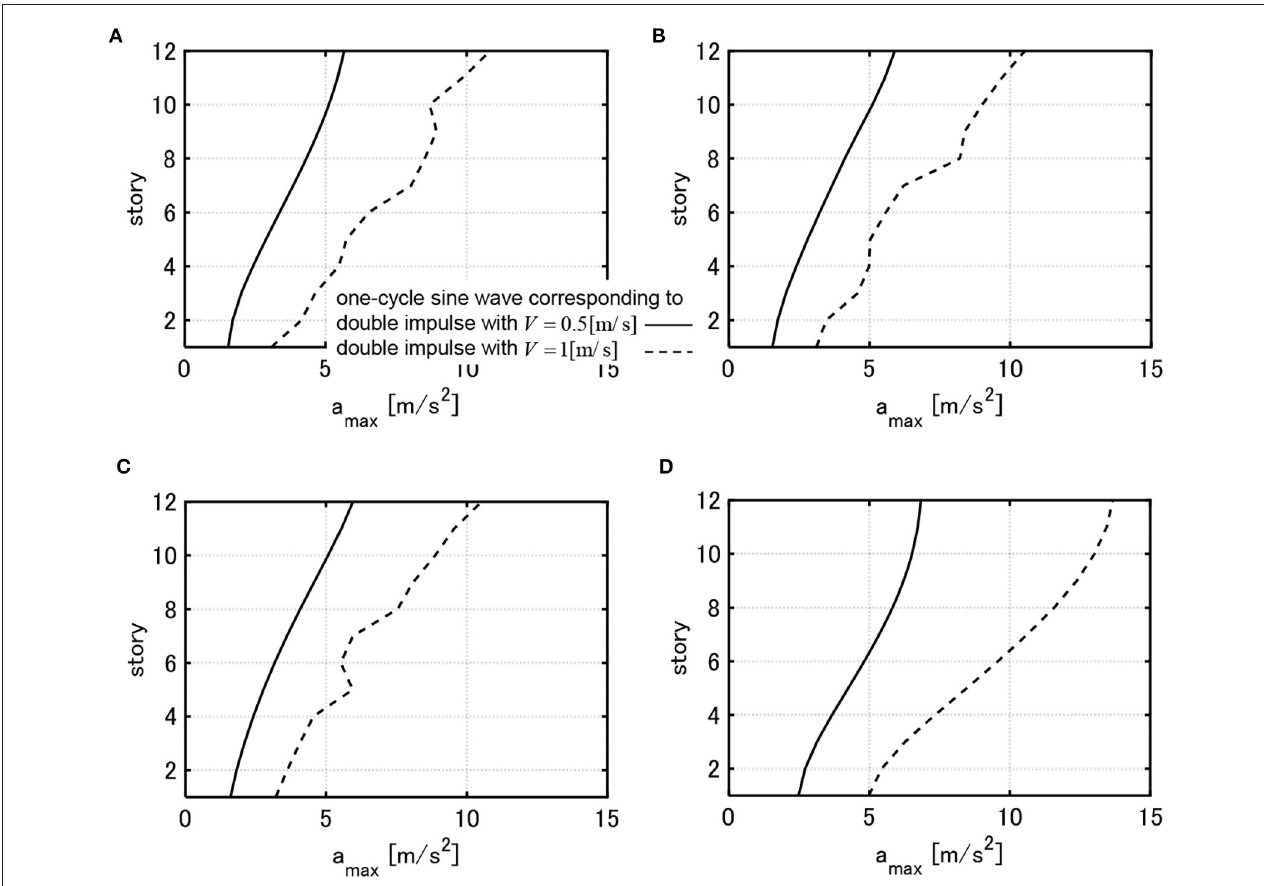
FIGURE 14 | Maximum floor acceleration of 3 models with W cF = 5 × 10 7 [ Ns / m ] and these initial design model under one-cycle sine wave corresponding to critical double impulse with V = 0.5, 1.0[ m / s ]. (A) Model designed under critical double impulse with V = 0.25[ m / s ]. (B) Model designed under critical double impulse with V = 1.0[ m / s ]. (C) Model designed under critical double impulse with V = 1.5[ m / s ]. (D) Initial design.